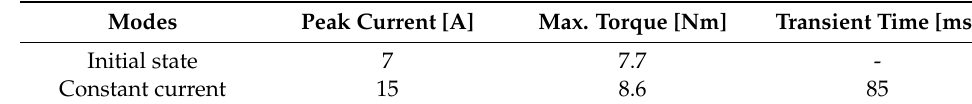
Figure 16. Block diagram for switching control from six- to three-phase operation.